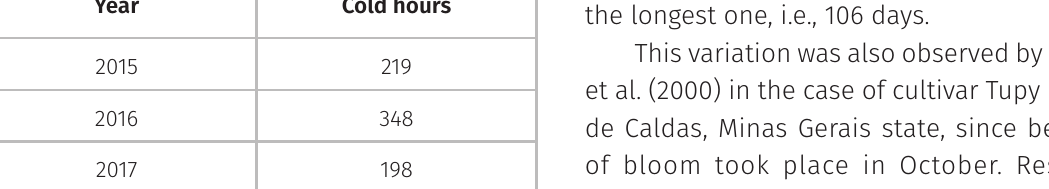
Source: Agrometeorology laboratory